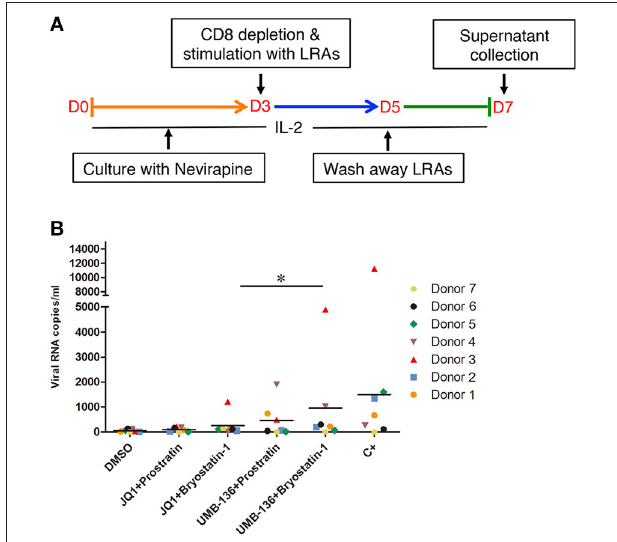
FIGURE 5 | Combined treatment with UMB-136 and Bryostatin-1 reverses HIV-1 latency in patient-derived CD8-depleted PBMCs. (A,B) CD8-depleted PBMCs isolated from seven cART-treated, HIV-positive aviremic patients were stimulated with UMB-136 (2.5 µ M), or JQ1 (1 µ M) in combination with PKC agonists (prostratin, 250 nM; bryostatin-1, 10 nM) to reactivate latent HIV-1 from reservoir cells. The viral transcripts from newly produced HIV-1 viruses in the supernatant were measured by a quantitative nested RT-qPCR assay. C + : antibodies against CD3 and CD28. * P < 0.05, wilcoxon signed rank